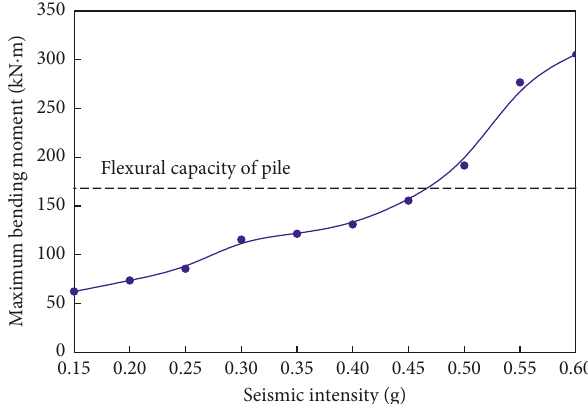
Figure 15: The maximum bending moments of the pile.